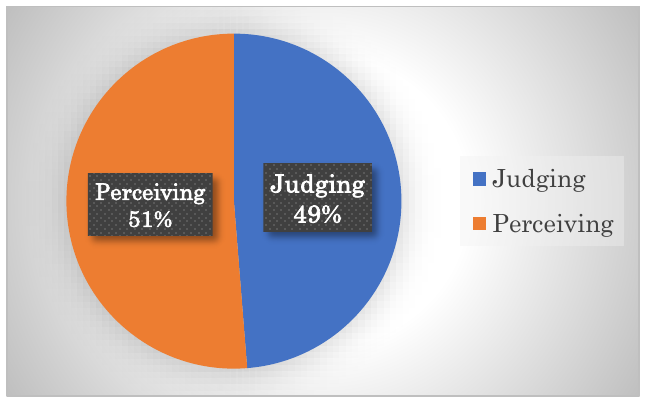
Fig. 5. Distribution of Class D in a